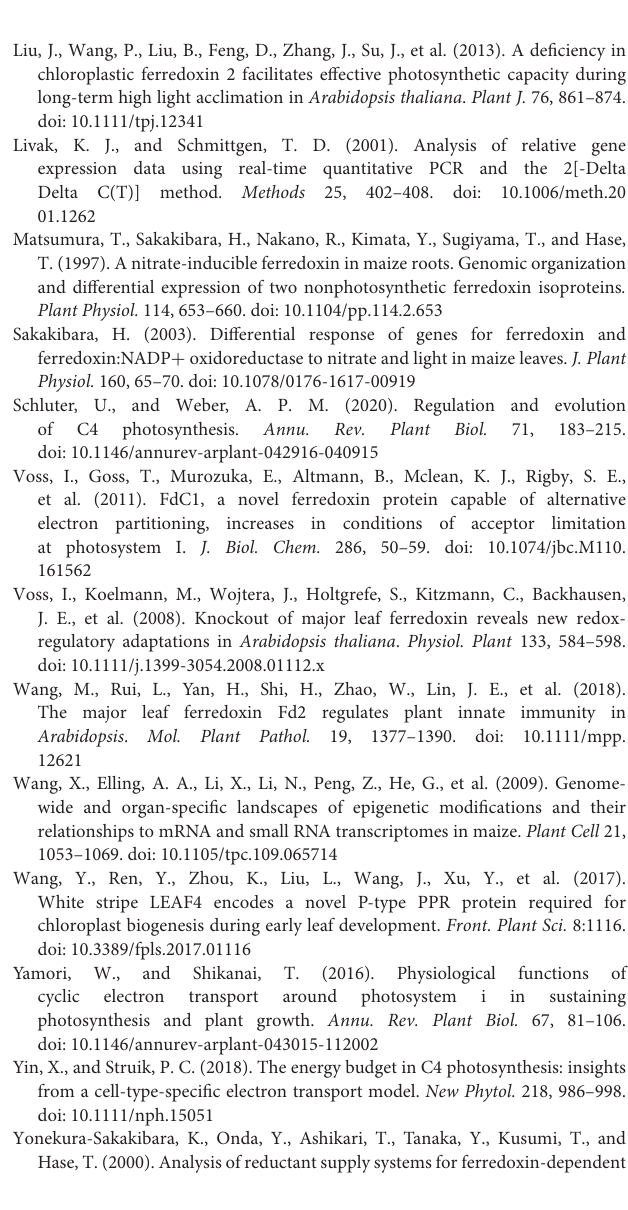
Supplementary Figure 1 | Separation of bundle sheath cells and mesophyll cells. The two types of cells were observed under light microscope. Round cells on the right are the mesophyll protoplast cells, and the tubelike structures on the left are the bundle sheath tissue. Supplementary Figure 2 | ZmFdC2 expression in HZM and pas1. The youngest leaves of 7-day-old seedlings from HZM and pas1 were subjected for RNA isolation. Gene expression was normalized to HZM. Maize Actin gene served as internal control. The quantifications were from three biological replicates. Supplementary Figure 3 | 3-D structure simulation of ZmFdC2 and ZmFdC2m proteins. N and C indicated N- and C-terminus of the proteins. Supplementary Table 1 | Primers used in this study. Supplementary Table 2 | Segregation of F 2